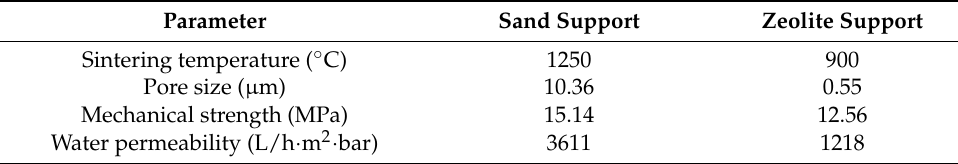
Table 1. Characteristics of sand and zeolite supports. Parameter Sand